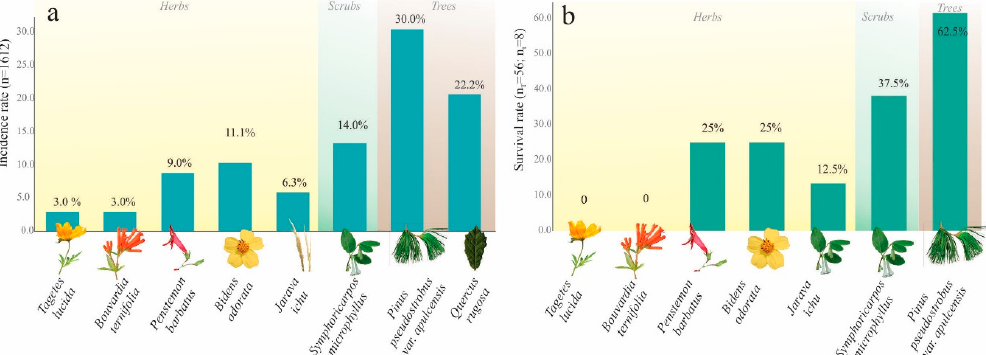
Figure 11. Host preferences of Ocoaxo assimilis in Nicolas Bravo, Puebla. a) The rate incidence of insects collected in the field (nymphs and adults) on the roots of eight host plants; n total number of insects collected (= 1612); percentages at the top of bars were calculated with respect to “n”. Survival rates of nymphs of O. assimilis under controlled conditions to evaluate the feeding preferences among herbaceous, bush, and arboreal host species. nT, the total number of insects analyzed considering the seven host species (56); nt, the total number of analyzed insects per host plant (8); percentages were calculated respect to nt. b) The results of experiments to evaluate the paired selection of tree hosts and the respective development of Ocoaxo assimilis nymphal specimens from nymphal stage “S4” to adults.